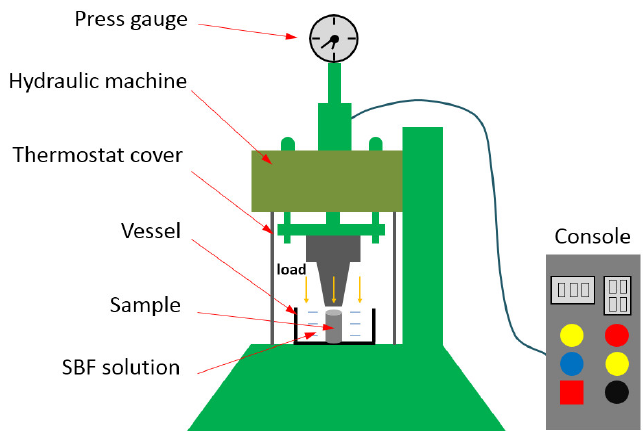
Figure 1. Schematic of the experimental facility that offers a chemistry-mechanics interactive environment. Table 1. Different treatment conditions of experimental alloys.